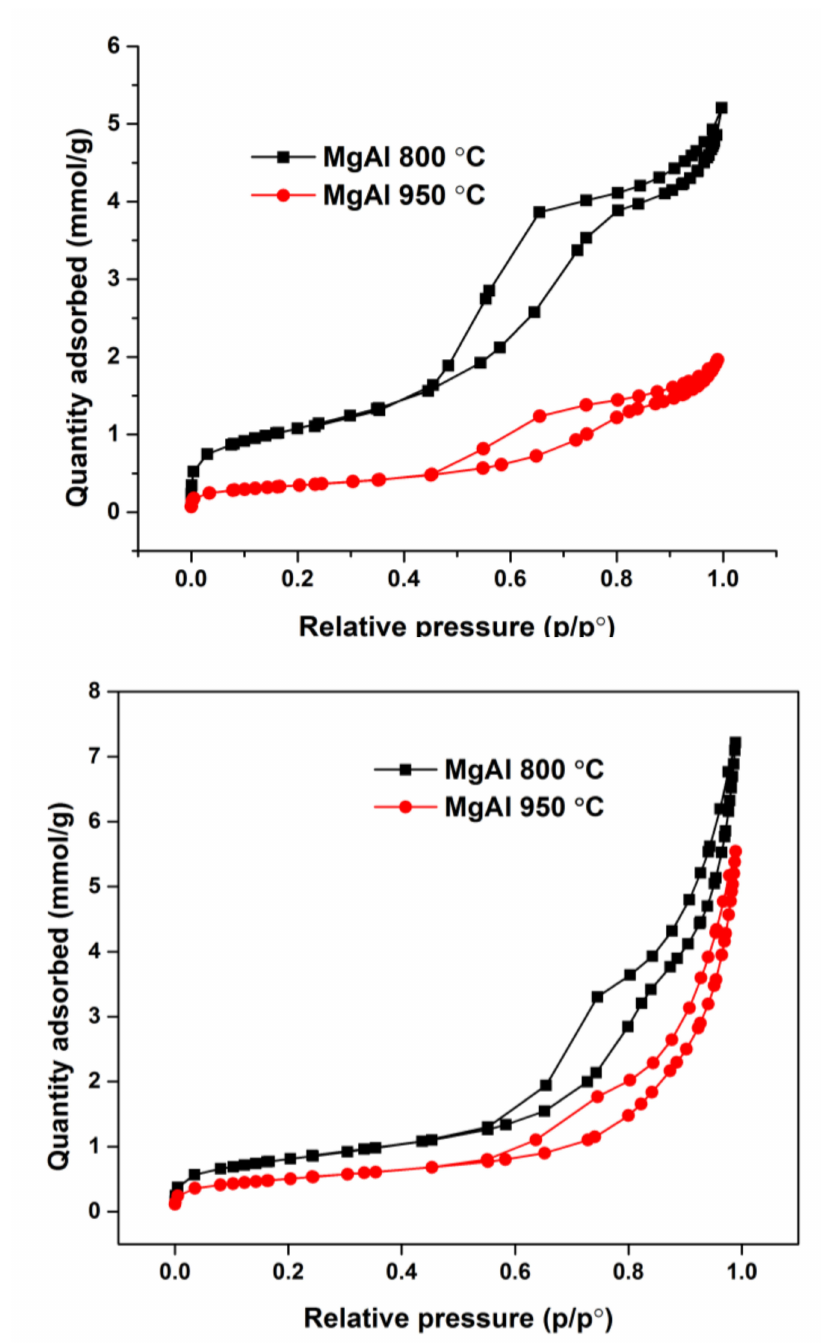
Figure 12. Nitrogen adsorption–desorption isotherms of mixed metal oxides (MMO) obtained by heating the Mg 2 / Al 1 precursor gels ( top ) and obtained by heating the Mg 2 Al 1 LDHs ( bottom ) at 800 ◦ C and 950 ◦